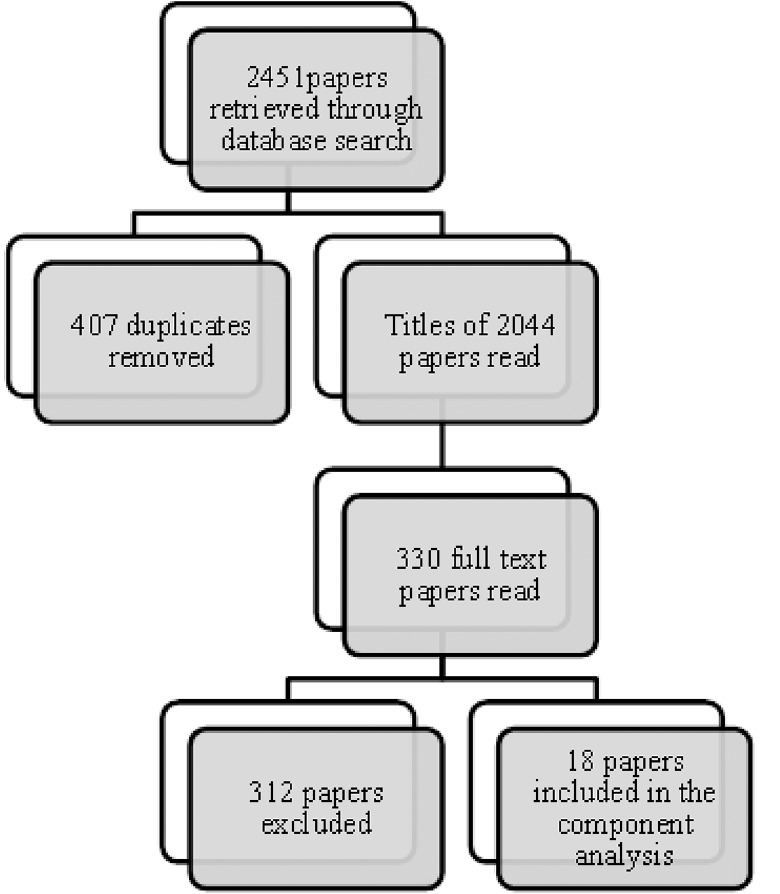
Fig 2. Selection process of papers included in the component